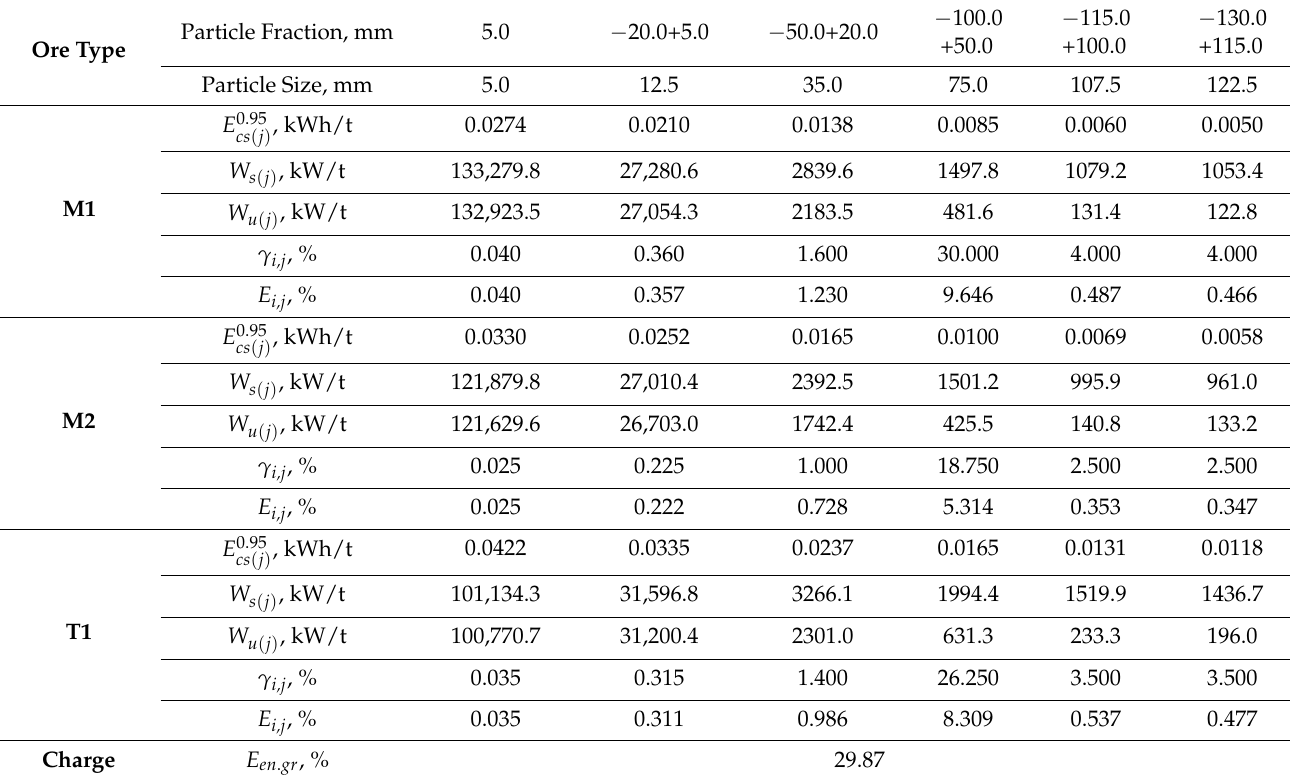
Figure 16. Graphic interpretation of principal determining useful energy on an energy spectra using the nominal specific energy value. Table 6. Semi-autogenous grinding efficiency